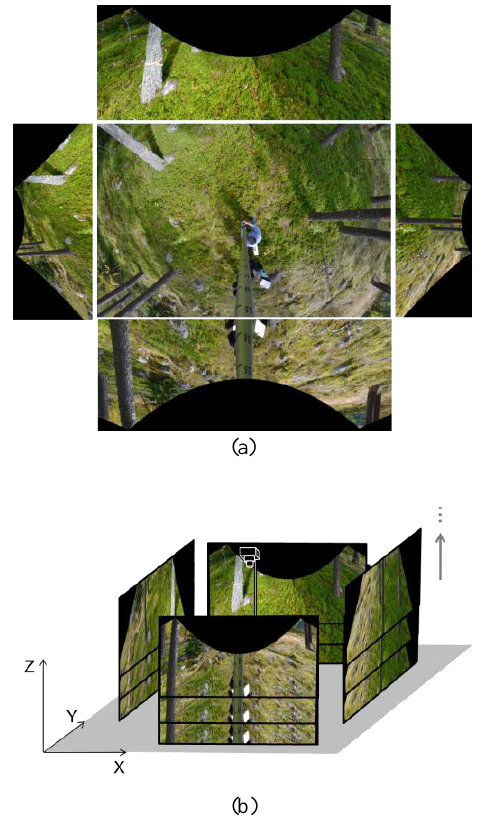
Figure 2. (a) Vertical fisheye image rectified to four horizontal lateral views. (b) Lateral image sequences simulating photogrammetric